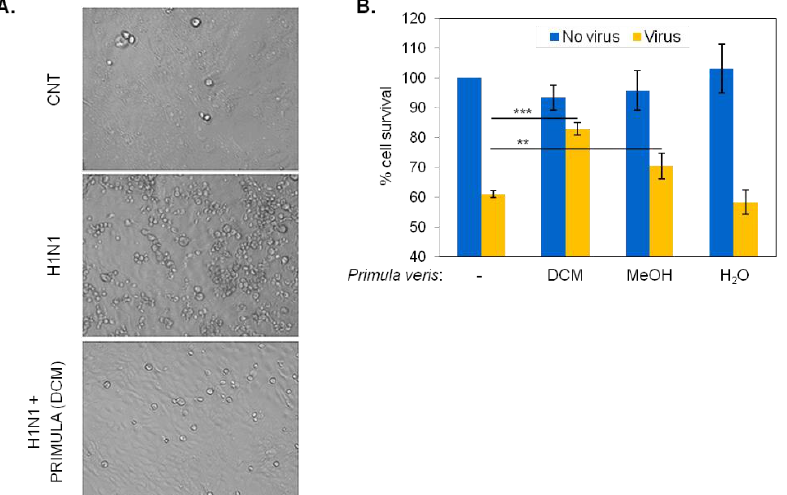
Figure 2. Virucidal effects of P. veris non-polar (DCM), medium-polarity (MeOH) and polar (H 2 O) extracts. ( A ) Microphotographs of MDCK cells infected with H1N1 (MOI = 0.1) or with virus that had been pre- incubated for 1 h with 50 μg/mL of P. veris non-polar (DCM) extract. Rounded cells are indicative of virus-induced cytotoxicity. CNT: uninfected control cultures. ( B ) Collective data of MDCK cell survival, assessed by MTT conversion assays, following infection with either H1N1 alone or P. veris extract-treated H1N1, as described in ( A ). Data are the average of duplicate determinations from 3 independent experiments. (*** p < 0.001; ** p < 0.01 Student’s t -test).